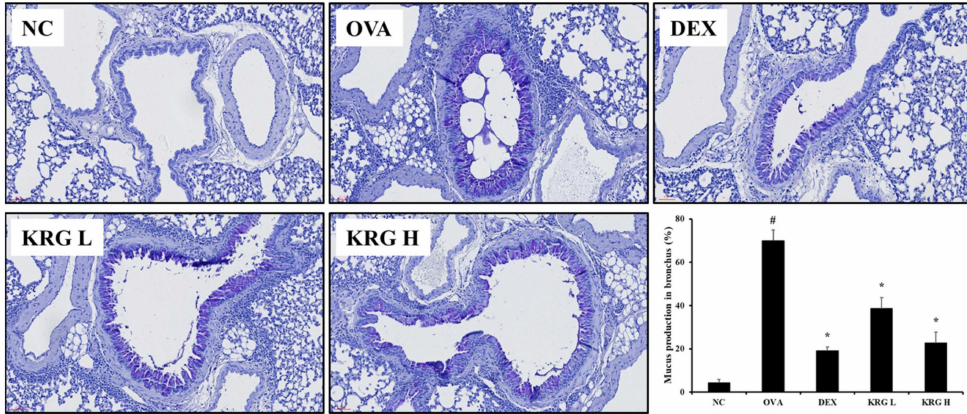
Figure 4. Korea red ginseng (KRG) inhibits the mucus overproduction in the lung tissue induced by ovalbumin (OVA) treatment. Quantitative analyses of mucus production were performed utilizing an image analyzer. Normal control (NC) group; mice administered with the vehicle, OVA, group; mice treated with OVA and administered with the vehicle, dexamethasone (DEX), group; mice treated with OVA and administered with dexamethasone (3 mg/kg); KRG low (KRG L) and high (KRG H) groups; mice treated with OVA and administered with KRG (100 and 300 mg/kg, respectively). Values: means ± standard deviation ( n = 6). Significance: # p < 0.05 vs. NC; * p < 0.05 vs.